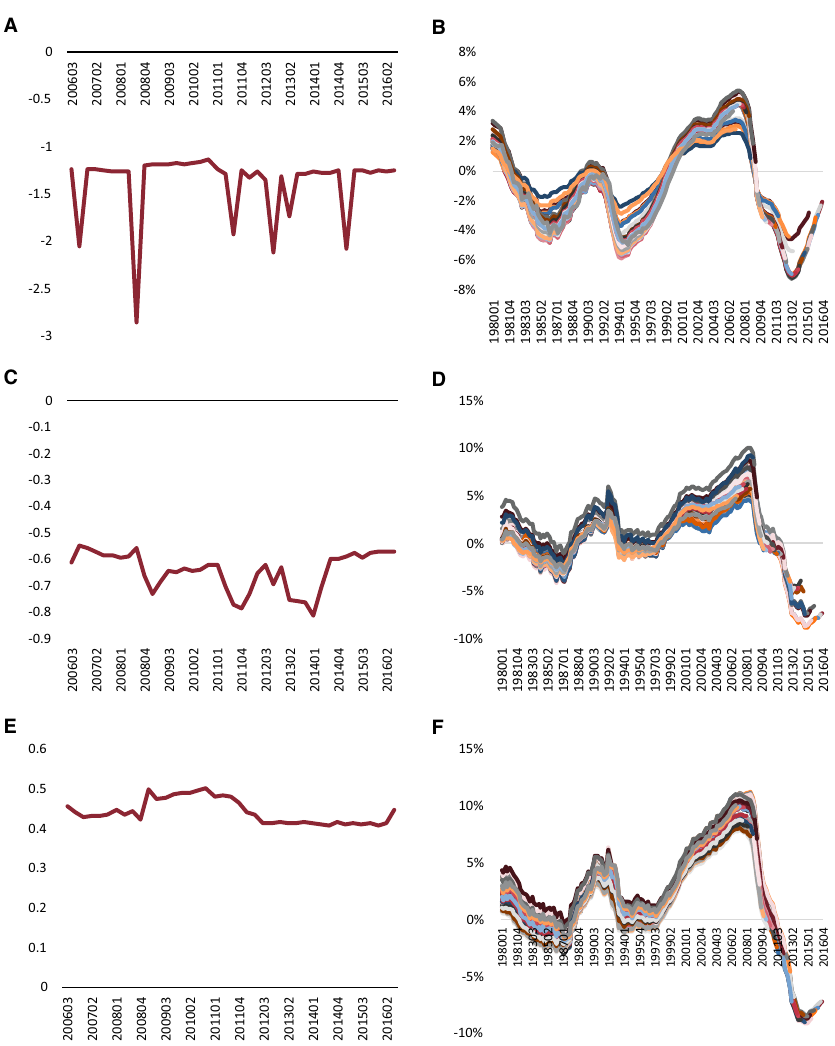
Fig. 3 Backtest, selected variables. a Recursive coefficient, unemployment cycle, b recursive output gap, unempl. model, c recursive coefficient, current account cycle, d recursive output gap, curr. acc. model, e recursive coefficient, construction cycle, f recursive output gap, construction model. Source of data : author’s